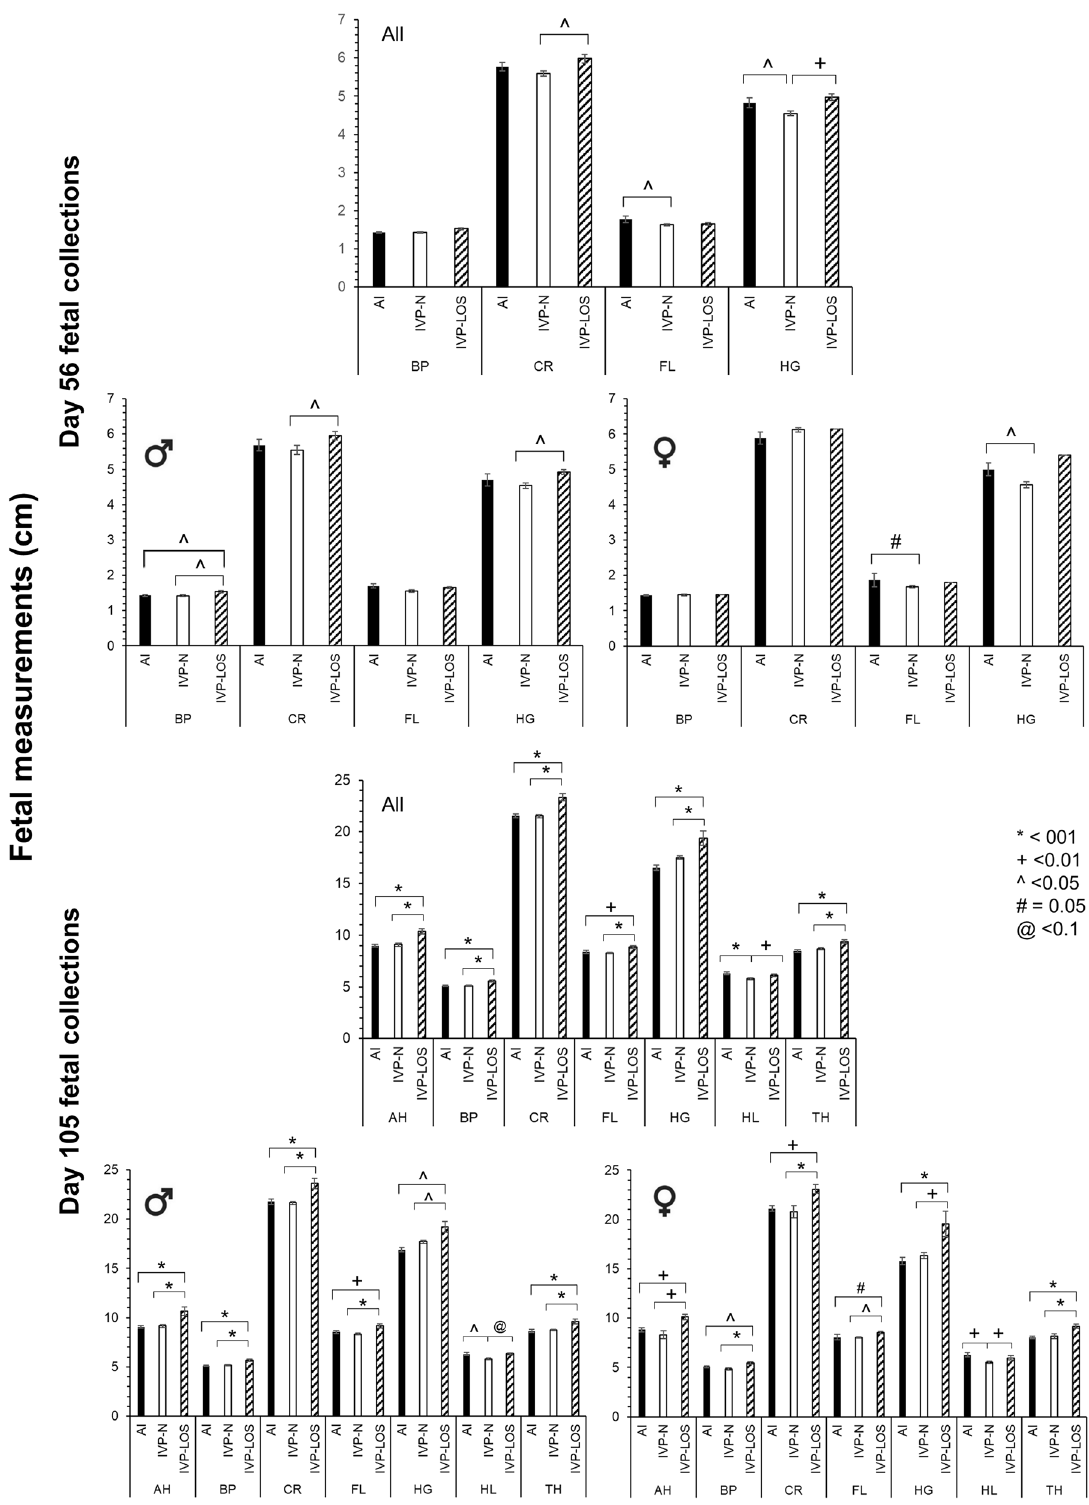
Figure 3. Fetal measurements at collection. Top three panels—D56 fetal measurements at collection (n = 6 females and 8 males in the AI group and 22 females [1 LOS] and 21 males [8 LOS] in the IVP group). Bottom three panels—D105 fetal measurements at collection (n = 4 females and 8 males in the AI group and 13 [9 LOS] females and 33 males [8 LOS] in the IVP group). For each day set, the top graph includes both sexes and the bottom two graphs are separated by sex, males on the left and females on the right. BP biparietal diameter, CR crown-rump length, FL forelimb length, HG hearth girth, AH abdominal height, HL head length, TH thoracic height. Data are represented as average ± SEM. Lines going over three bars are used to represent statistical differences between the first and the third